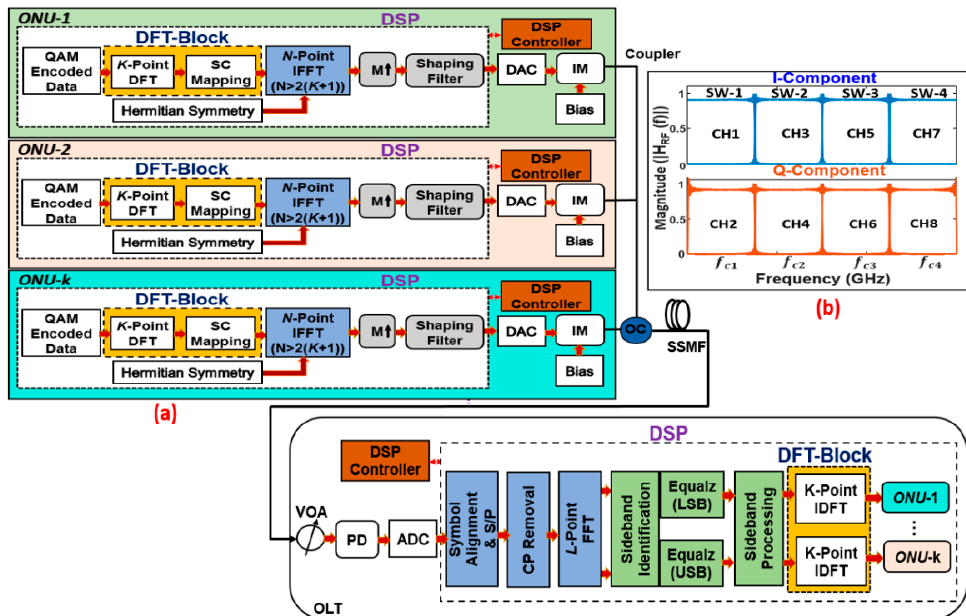
Figure 1. ( a ) DFT-spread hybrid OFDM–DFMA PON. ( b ) A schematic example of the ONU